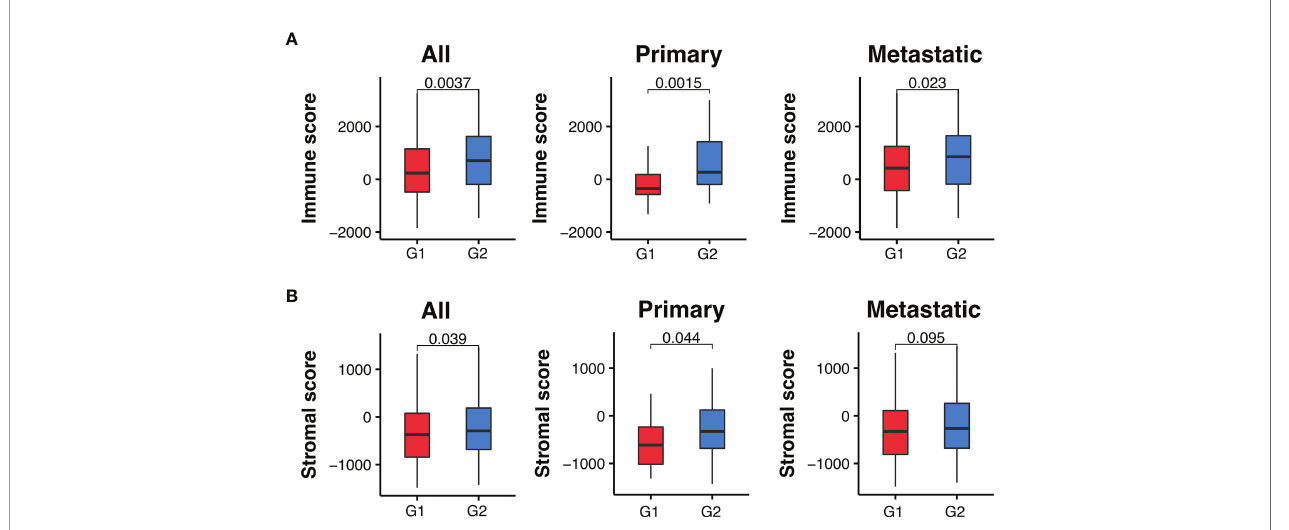
FIGURE 5 | Melanoma samples with ≥ 7 recurrent mutations (G1) have lower immune and stromal scores than those with <7 (G2). (A) Comparison of immune scores between recurrent and non-recurrent mutations in all, primary and metastatic melanoma samples. (B) Comparison of stromal scores between recurrent and non-recurrent mutations in all, primary and metastatic melanoma samples. P adj -values were calculated using two-sided Wilcoxon rank-sum tests and adjusted for multiple testing by the Holm – Bonferroni method.